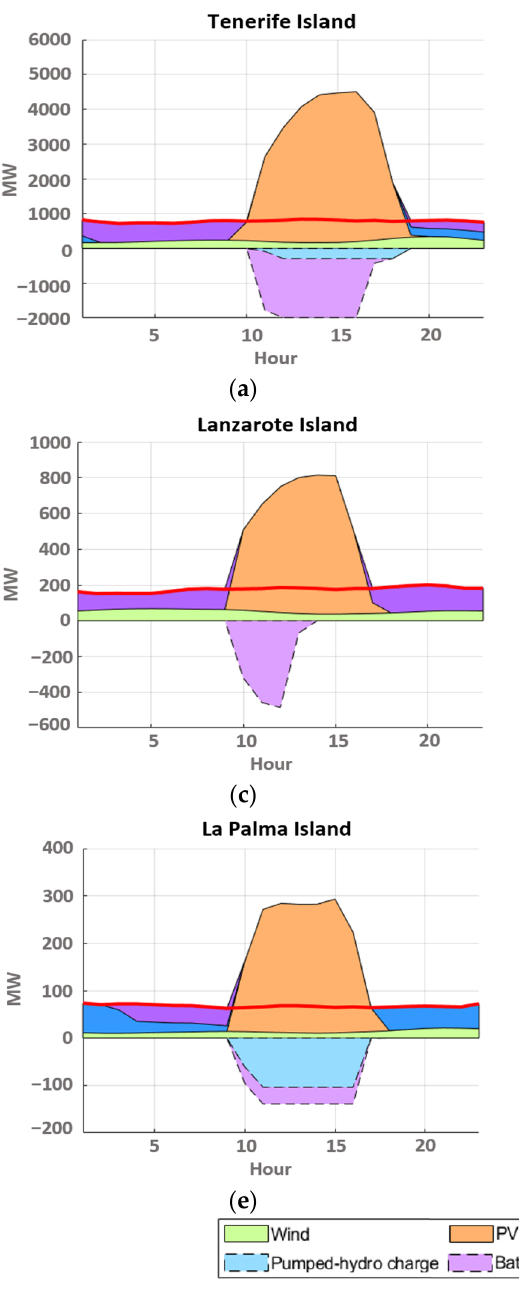
Figure 16. Hourly performance of the generation and storage systems on a typical winter day. ( a ) Tenerife; ( b ) Gran Canaria; ( c ) Lanzarote; ( d ) Fuerteventura; ( e ) La Palma; ( f ) La Gomera.